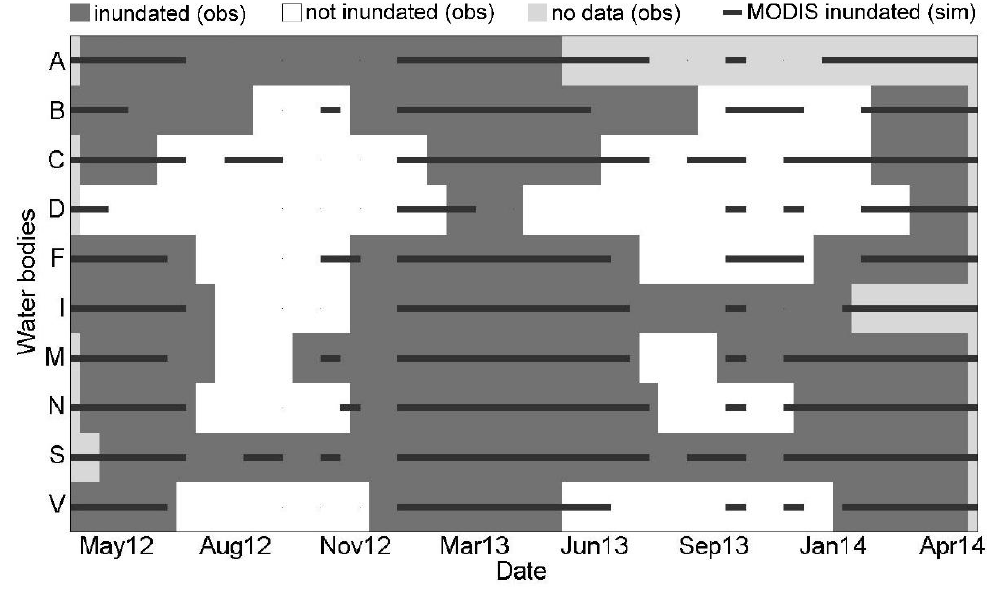
Figure 5. Comparison of ground-based (darkgrey and white boxes) and satellite-based (darkgrey line) inundation assessment for all studied water bodies (Figure 1) over the study period (1 April 2012–30 March